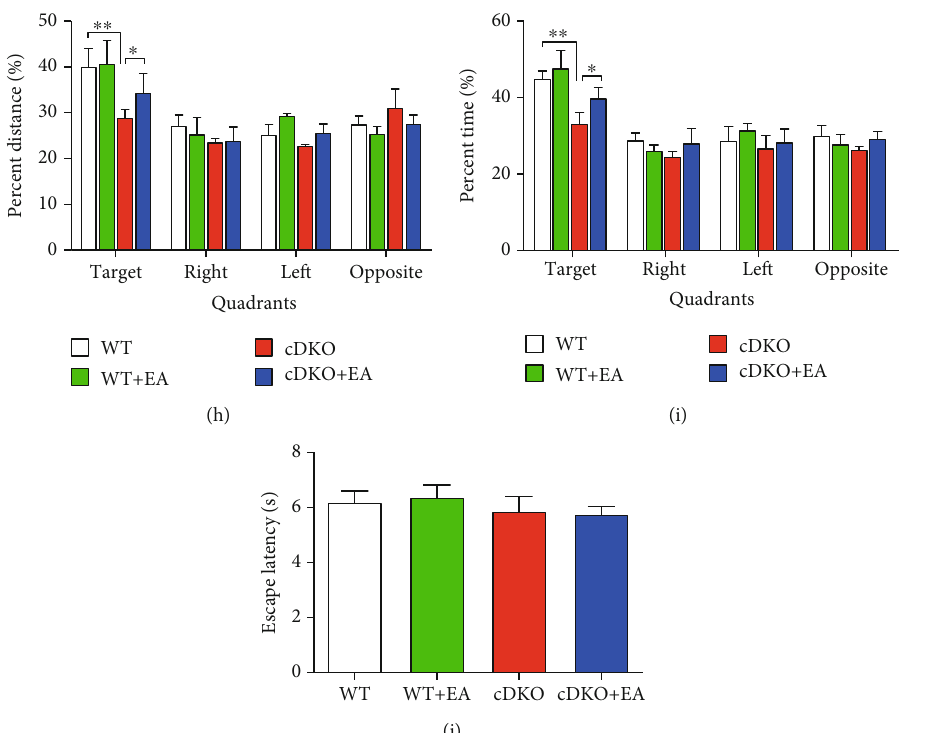
Figure 1: EA treatment ameliorates impaired memory in PS cDKO mice. (a) The experimental timeline of habituation, EA stimulation, and behavioral tests. (b) E ff ects of EA treatment on recognition memory in PS cDKO mice by NOR task. (c, d) The duration spent and frequency visited in the novel arm of the Y-maze. (e) The escape latency to the hidden platform in target quadrant during the fi rst phase of 5 consecutive training days of the MWM test. (f) Mice of four groups exhibited no di ff erences in swimming speed in the MWM test. (g) Platform crossing times in the second phase, probe trial on day 6 of the MWM test. (h, i) Percentage of distance swim and time spent in the target quadrant during the probe trial of the MWM test. (j) Escape latency to the visible platform without di ff erences among the four groups in the MWM test. ( n = 8 mice for each group). Data are the mean ± S : E : M : , ∗ p < 0 : 05 , ∗∗ p < 0 : 01 vs WT mice. # p < 0 : 05 , ## p < 0 : 01 vs cDKO